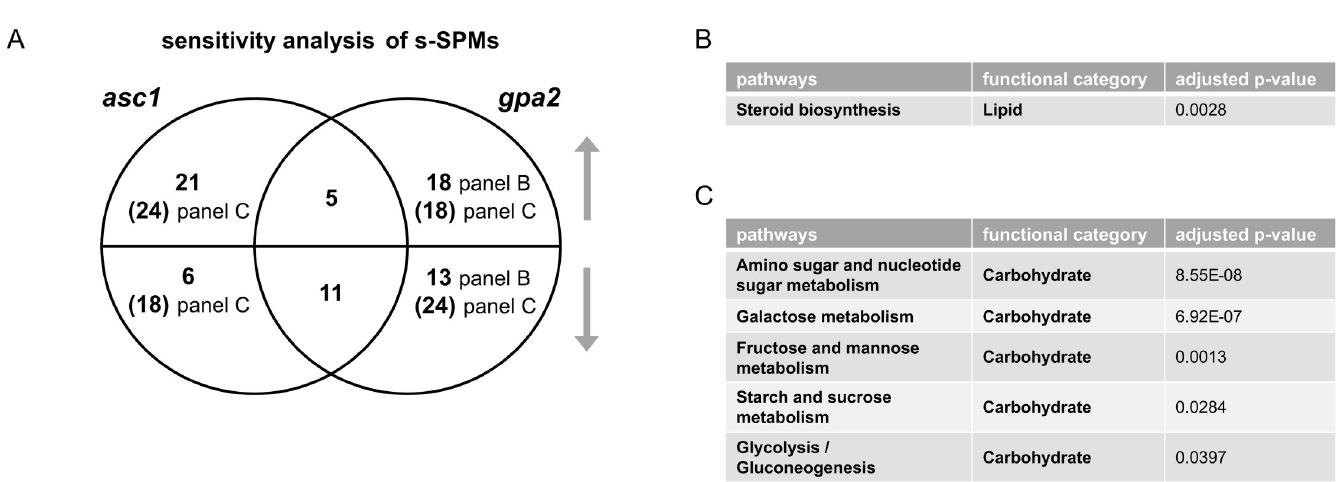
Fig 6. Sensitivity analysis of significantly perturbed metabolites (s-SPMs) after glucose addition. A) Venn diagram of subsets of s-SPMs, before and after glucose addition for each mutant (mutantH-mutantL) and wildtype (wtH-wtL). Upper semicircle shows up-regulated s-SPMs and lower semicircle shows down-regulated s- SPMs. Numbers in parenthesis are shared s-SPMs regulated in the opposite direction, placed in the area corresponding to the direction of regulation. Subset of s-SPMs used for ORA analysis that are B) unique to gpa2 ; C) shared and changed in the opposite direction. Shared s-SPMs changed in the same direction and s-SPMs unique to asc1 are not over-represented in any pathway and are therefore not shown. Listed are all pathways and their functional categories with adjusted p-value < 0.05.